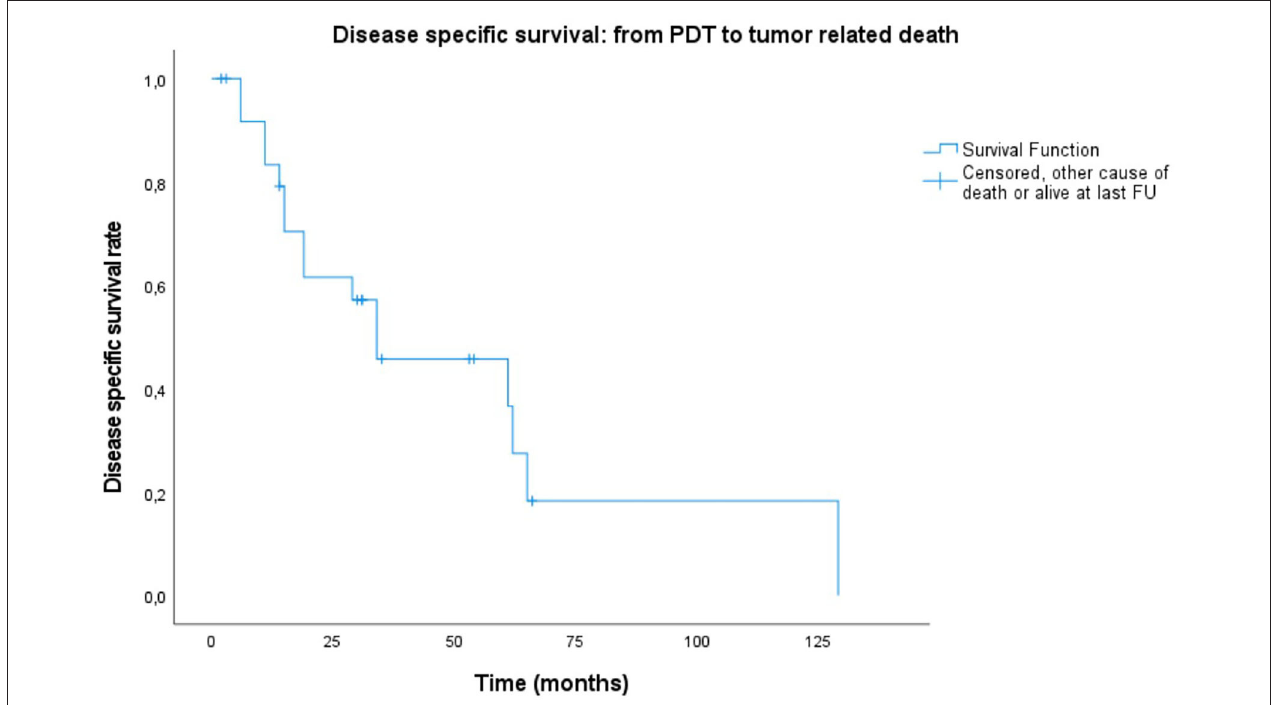
FIGURE 3 | Kaplan–Meier plot showing disease-specific survival from PDT illumination date to endpoint defined as either tumor related death, other cause of death or alive at last follow-up (FU).